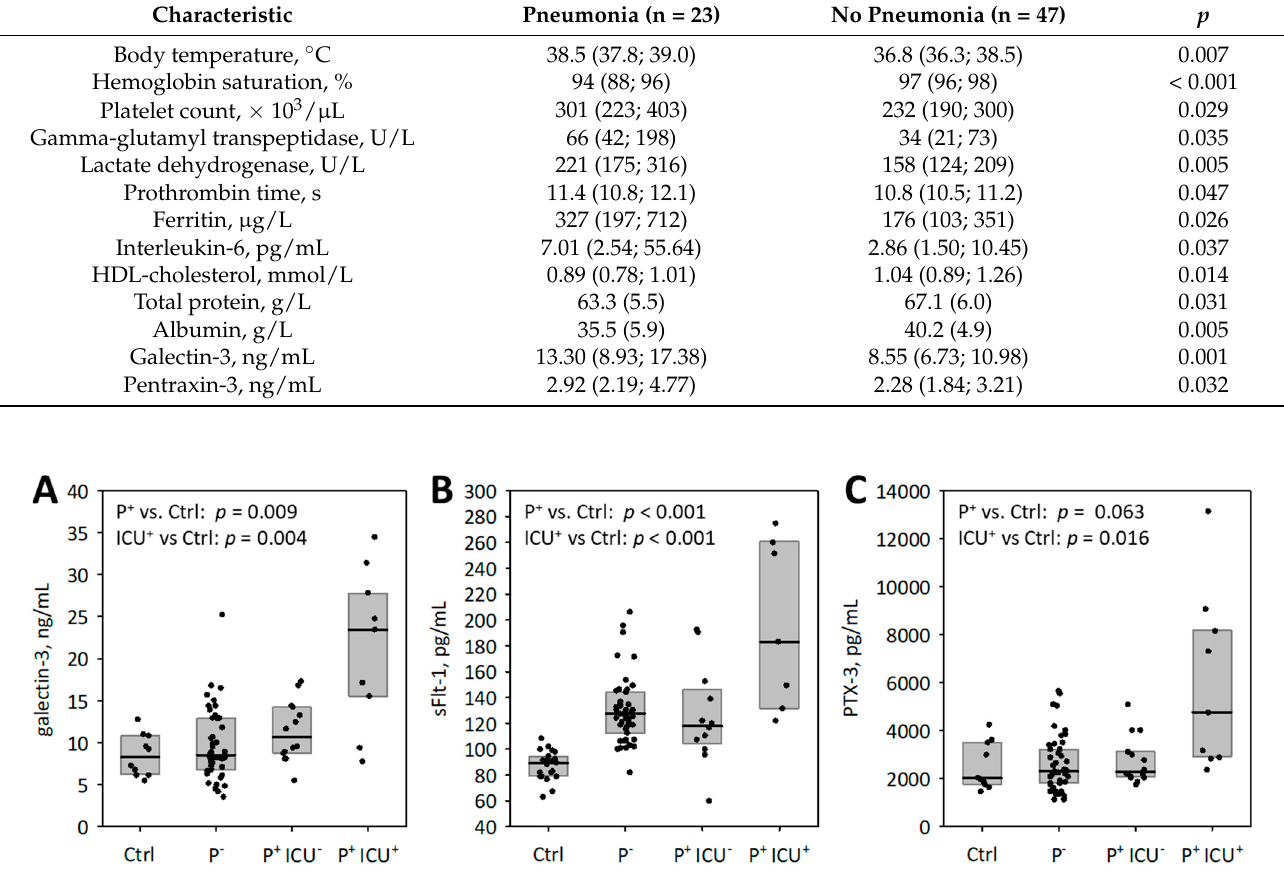
Figure 1. Serum concentrations of galectin-3 ( A ), soluble fms-like tyrosine kinase-1 (sFlt-1; B ), and pentraxin-3 (PTX-3; C ) among studied patients with COVID-19 of various severity in comparison to healthy controls (Ctrl). P − denotes COVID-19 patients without pneumonia; P + indicates those with pneumonia, including patients not requiring (ICU − ) and those requiring treatment in the intensive care unit (ICU + ). Data are shown as median (line), interquartile range (box), and raw data (points); p -values from the Mann–Whitney test are reported. Table 4. Statistically significant differences between patients who required and did not require treatment in intensive care unit (ICU) during hospital stay. Data are shown as median (IQR) or mean